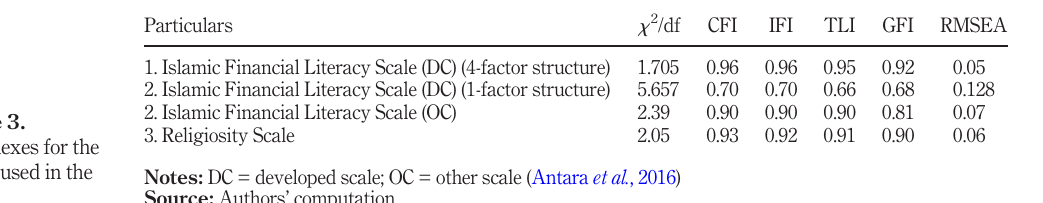
Table 3. Fit indexes for the scales used in the study